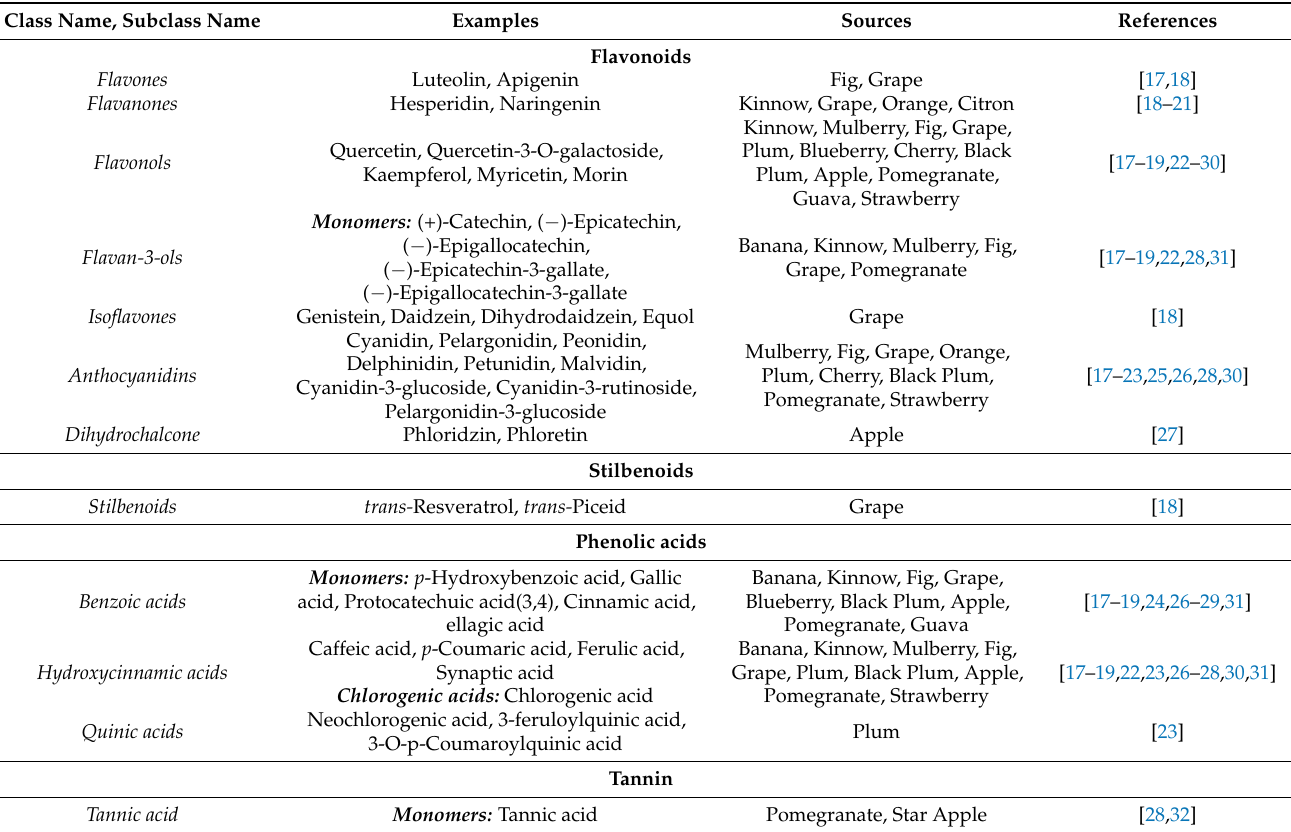
Table 3. Polyphenols: classes, subclasses, and fruit